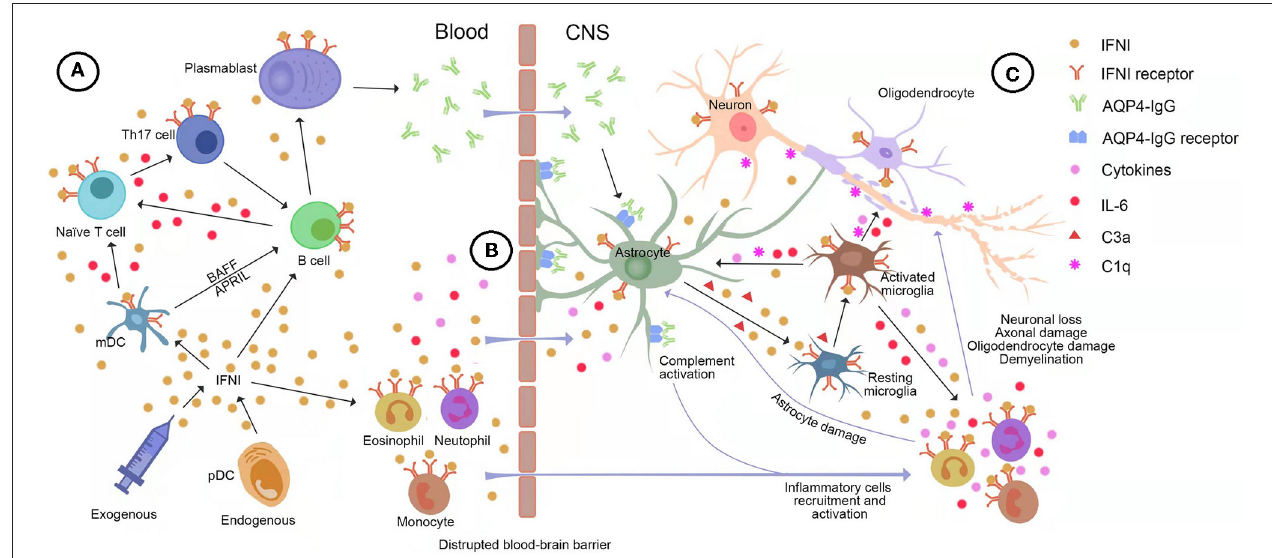
FIGURE 3 | The potential role of type-I interferon (IFNI) signaling in the immunopathogenesis of neuromyelitis optica spectrum disorder (NMOSD). (A) Both endogenous and exogenous IFNI can drive B cells and myeloid dendritic cells (mDC) to produce large quantities of interleukin (IL)-6, which stimulates naive T cells to transform into inflammatory Th17 cells. Moreover, plasmacytoid dendritic cells (pDC) secretes IFNI into mDC, facilitating the generation of BAFF and APRIL, which are essential for the survival and maturation of B cells. In turn, inflammatory Th17 cells help B cells differentiate into AQP4-IgG-secreting plasma cells. (B) IFNI drives IL-6 and other pro-inflammatory molecules to disrupt and increase the permeability of the blood-brain barrier (BBB), allowing AQP4-IgG, pro-inflammatory cytokines, and immune cells to infiltrate the brain. (C) The IFNI-dependent astrocyte-microglia interaction drives the development of NMOSD pathology. Astrocytes are highly responsive to IFNI and the predominant source of IFNI in the central nervous system (CNS). The binding of AQP4-IgG to astrocytes induces massive production of IFNI and complement C3a, which results in the IFNI-dependent activation of microglia. Microglia respond to astroglial IFNI with the subsequent production of nitric oxide, inflammatory factors, complements, and downstream ISGs, which leads to a heightened activation state of microglia, immune cell recruitment, and complement-mediated CNS destruction. In turn, microglia secrete pro-inflammatory factors into astrocytes, especially IFNI, IL-1, IL-6, and TNF- α , leading to astrocyte activation, C1q production, and release of other pro-inflammatory factors feeding back to microglia. AQP4, aquaporin-4; APRIL, a proliferation-inducing ligand; BAFF, B-cell activating factor; BBB, brain blood barrier; C1q, Complement component 1 q; C3a, Complement component 3a; IFN, interferon; IFNI, type-I interferon; IL-6, interleukin-6; IL-11, interleukin-11; mDC, myeloid dendritic cells; pDC, plasmacytoid dendritic cells; Th17, T helper type 17 cell; TNF- α , Tumor necrosis factor- α